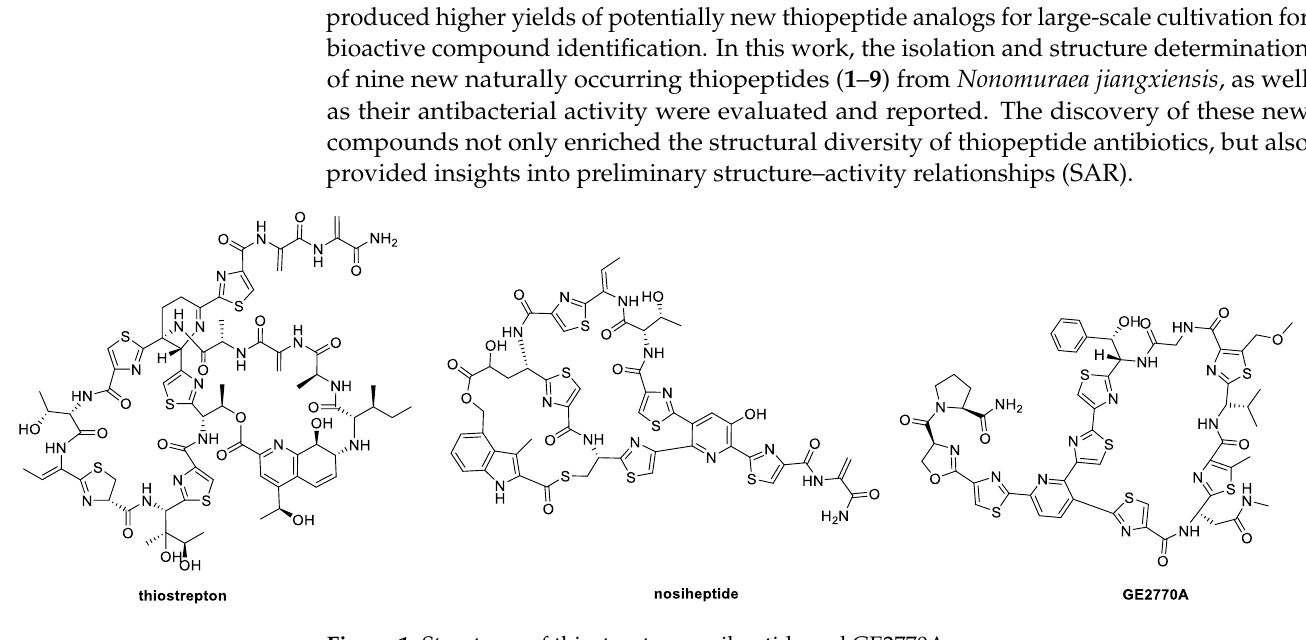
Figure 1. Structures of thiostrepton, nosiheptide and GE2770A.